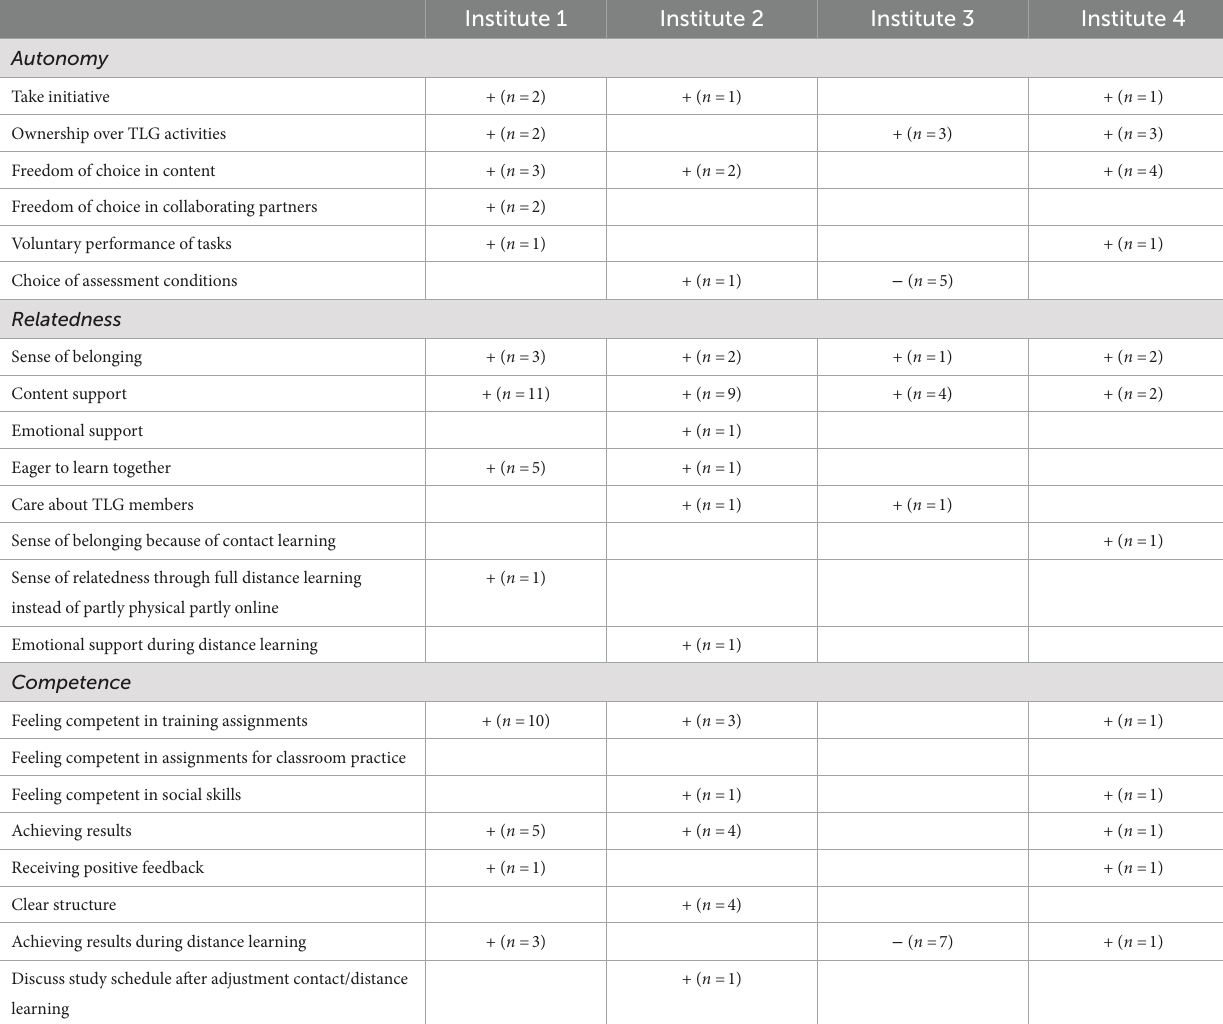
TABLE 6 Fulfilling of basic psychological needs in the four different